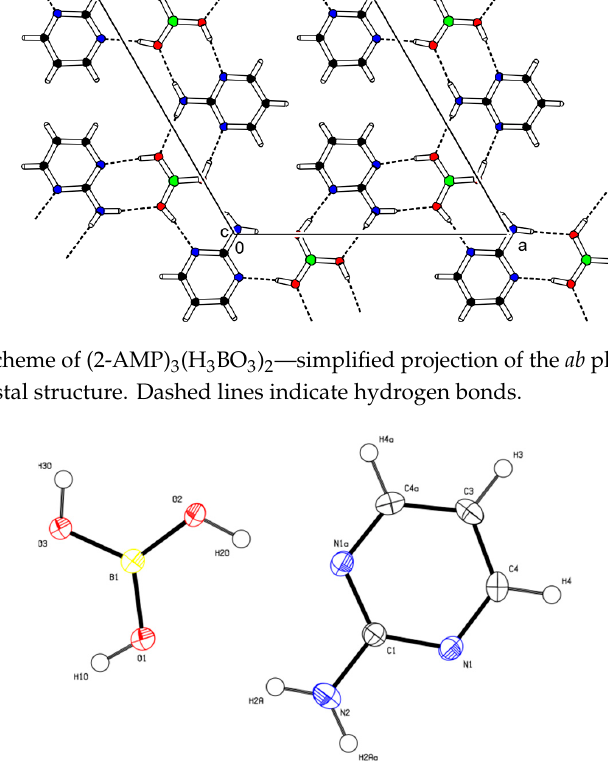
Figure 4. ORTEP plot of the asymmetric unit of 2-AMP(H 3 BO 3 ) 2 with atom numbering. The displacement parameters are shown at the 50% probability